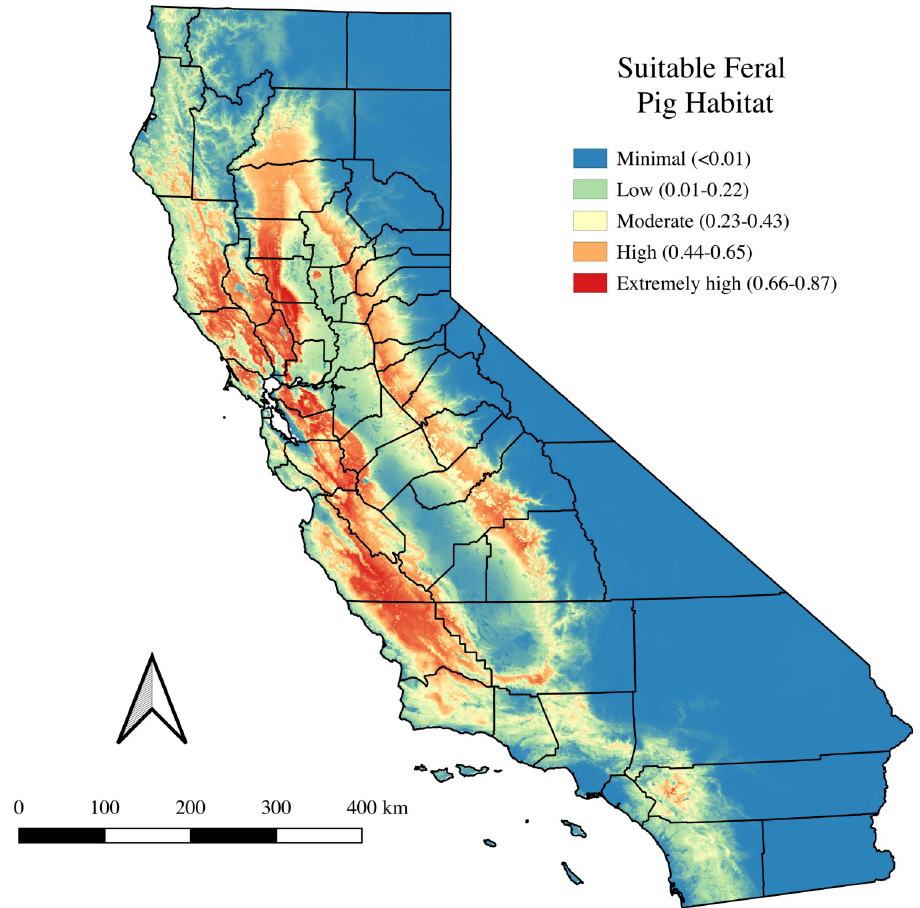
Fig 2. Final MaxEnt model predicting suitable feral pig habitat in California. Color-coded categories represent the probability of suitable feral pig habit on a scale of almost zero ( < 0.01) to extremely high (0.66–0.87), based on equal